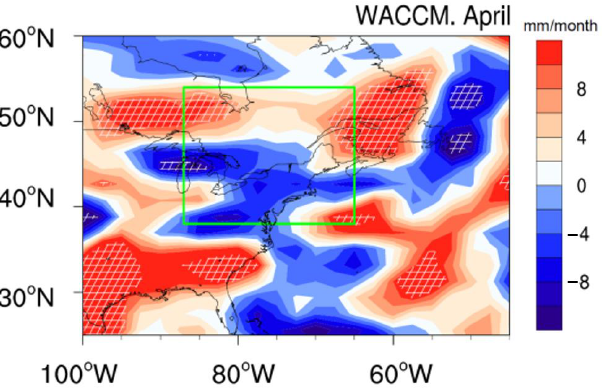
Figure 8. Differences in April precipitation between experiments E3 and E2 (mm/month). Cross-hatching denotes regions for which values are significant at the 90% confidence level.